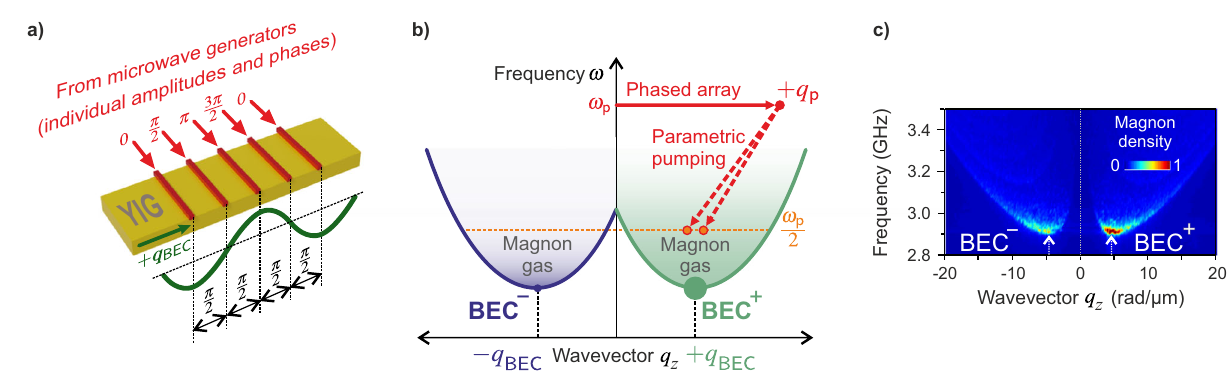
Fig. 2 Wavevector-selective parametric pumping and formation of an asymmetric magnon Bose – Einstein condensate (BEC). a Phased-array magnetic fi eld excitation mechanism. The red bars represent microstrip antennas placed on the surface of an yttrium-iron-garnet (YIG) fi lm. The wavevector þ q of BEC the BEC + component of the double BEC is directed along the magnetization direction z . b Schematic view of wavevector-selective parametric pumping scheme using microwave photons of frequency ω p with large wavenumbers q z ¼ q p ≳ þ 2 q . The red dashed arrows illustrate the process of decaying the BEC pump photon into two magnons with co-directional wavevectors. In this case, the density of magnon gas and the magnon condensate BEC + in the area of positive wavenumbers q z (the green shaded area and large green dot, respectively) signi fi cantly exceeds the density of magnon gas and the magnon condensate BEC − in the area of negative wavenumbers q z (the blue shaded area and small blue dot, respectively). c Micromagnetic modeling of BEC formation using such wavevector-selective parametric pumping. The color code indicates the normalized magnon